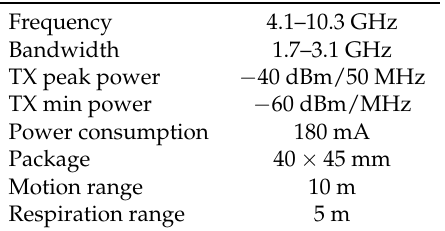
Table 2. Specification of UWB radar [27].